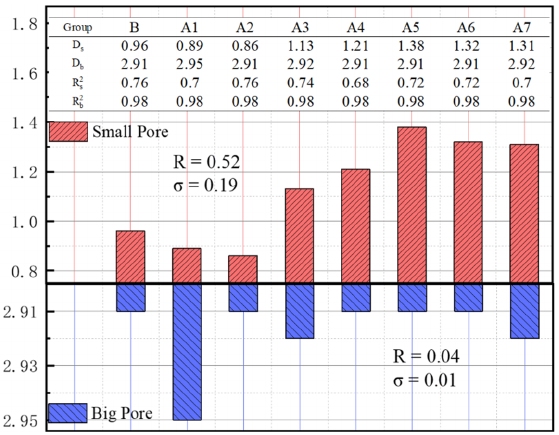
Figure 8. Fractal characteristics of representative groups.